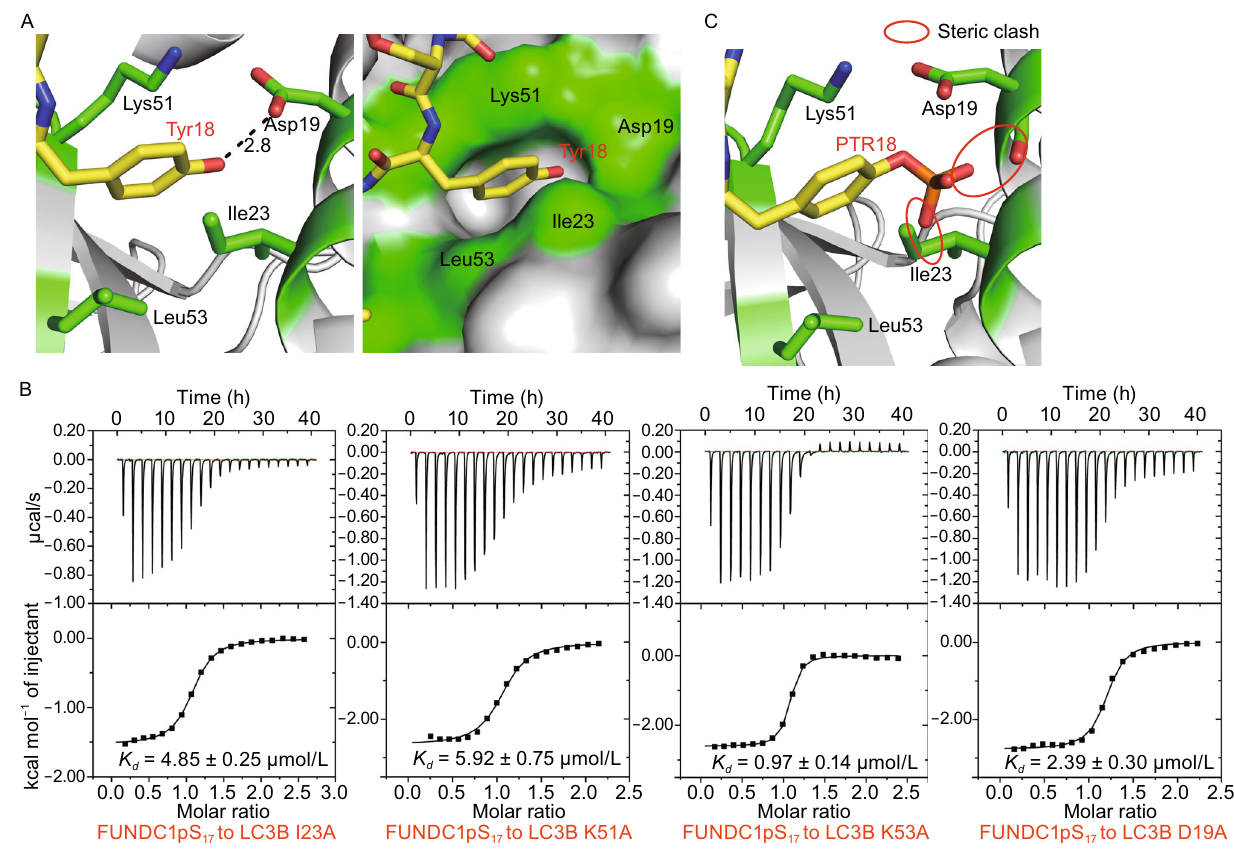
Fig. 3. The phosphorylation of FUNDC1 Tyr18 disrupts the interaction with the hydrophobic pocket of LC3B. (A) FUNDC1 Tyr18 inserts into the deep hydrophobic pocket of LC3B and forms a hydrogen bond with LC3B Asp19. The hydrogen bond is indicated as a black dash. The surrounding structure of LC3B is represented in grey. FUNDC1 Tyr18 is colored yellow and labeled in red. The residues of LC3B involved in the interaction with FUNDC1 Tyr18 (Asp19, Ile23, Lys51 and Leu53) are colored green and labeled in black. (B) The ITC fi tting results of the FUNDC1 pS 17 peptide with LC3B mutated at the above-mentioned positions. (C) The hypothetical model of PTR18 (phosphorylated Tyr18, phosphorylated by PyTMs) in the complex structure. The steric clash is highlighted with red